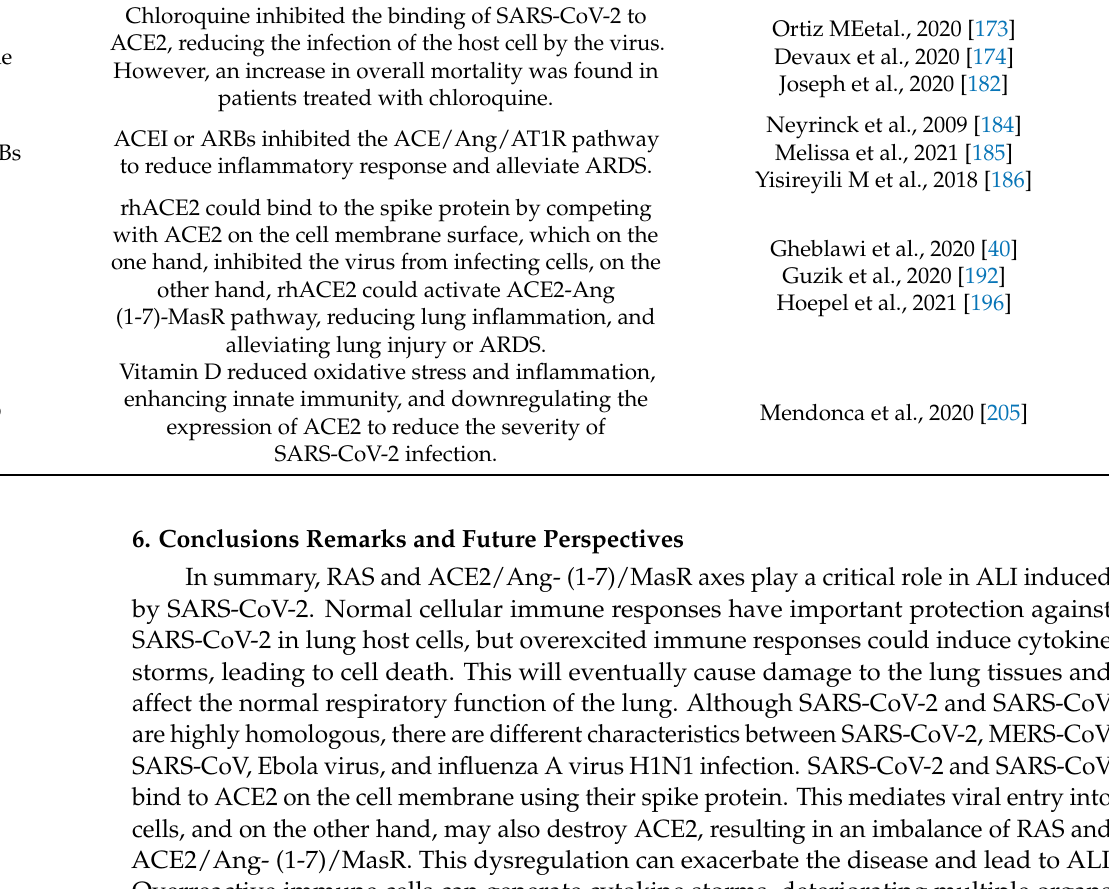
Table 1. The potential therapeutic role of ACE2 in SARS-CoV-2-induced acute lung injury.